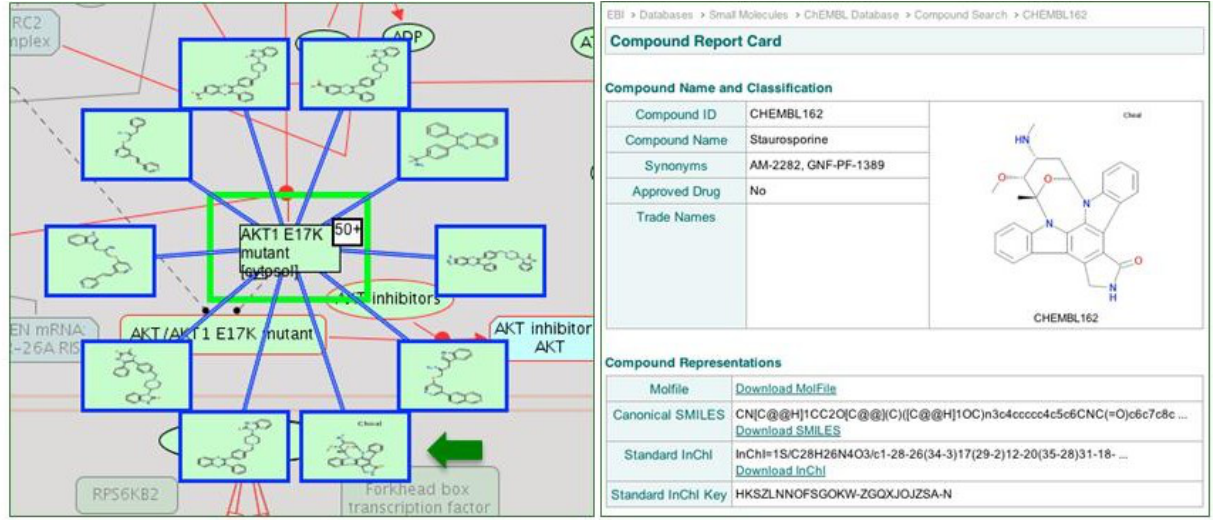
Figure 5. AKT1 E17K mutant-small molecule interactions. When ChEMBL is selected as the interaction database, the MI Overlay displays small molecules from ChEMBL as interactors of AKT1 E17K variant protein of the PI3K/AKT Signaling in Cancer pathway. The nodes of the mini network are interactive; clicking the node to the left of the green arrow will link out to the Staurosporine protein kinase inhibitor record at